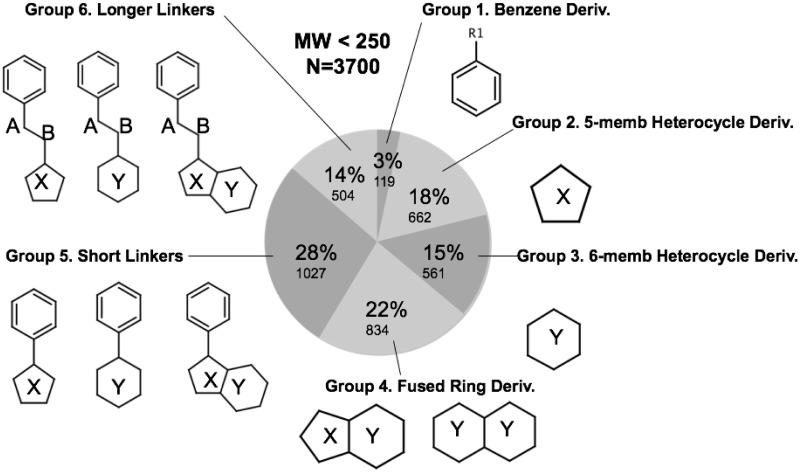
Aromatic heterocycle fragment replacement library.Additional details in supplementary information.